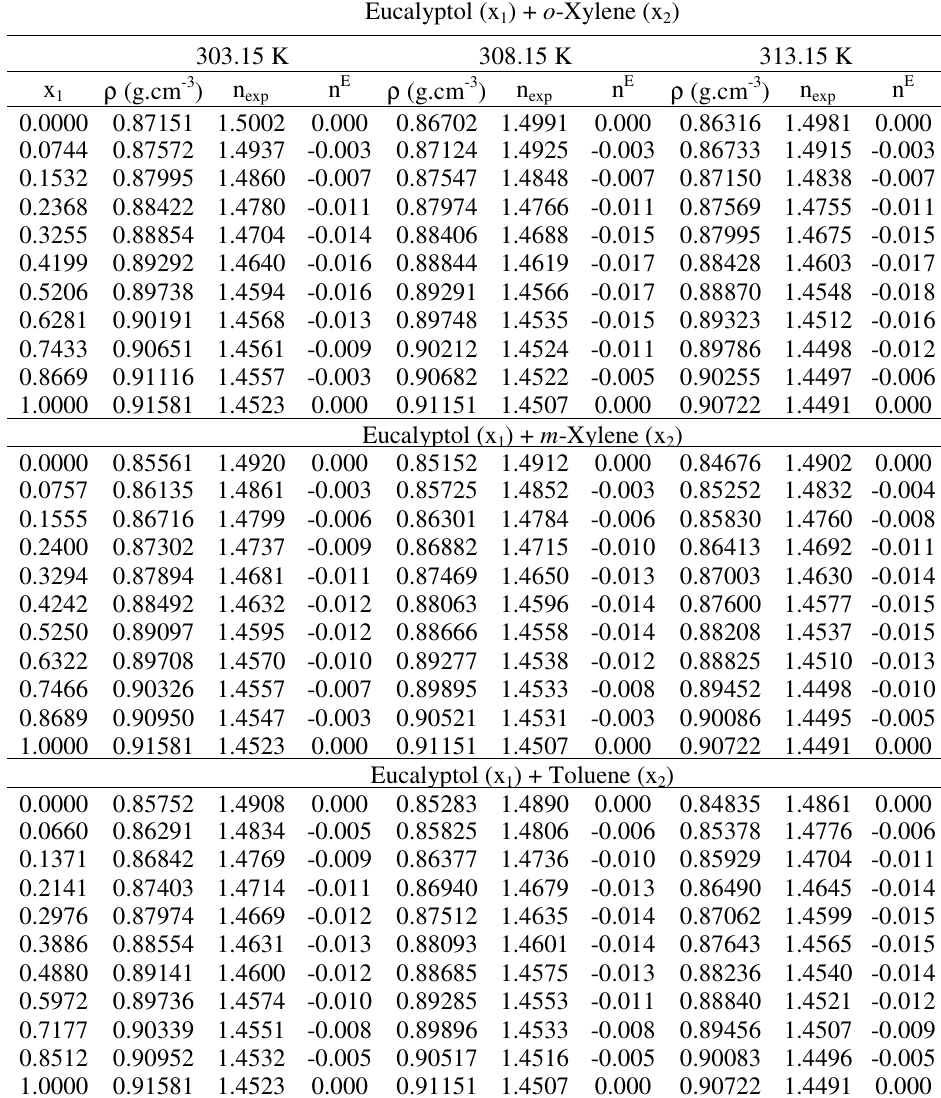
Table 1. Experimental Densities( ρ ), Refractive Indexes(n binary liquid mixtures of Eucalyptol with Hydrocarbons at 303.15K, 308.15K and